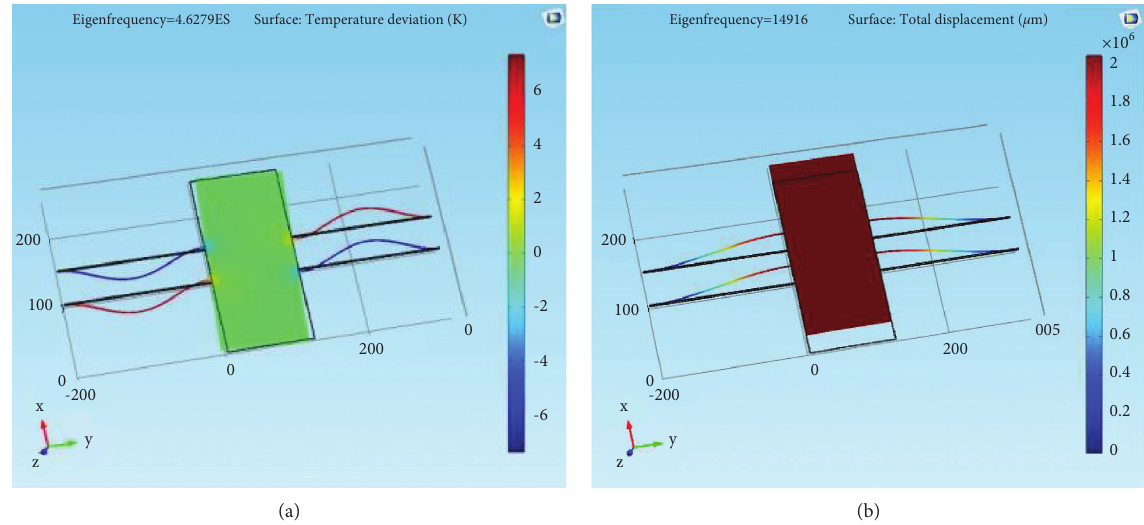
Figure 6: (a) Temperature distribution of a rectangular microplate with thermoelastic damping and (b) the displacement of a rectangular microplate with thermoelastic